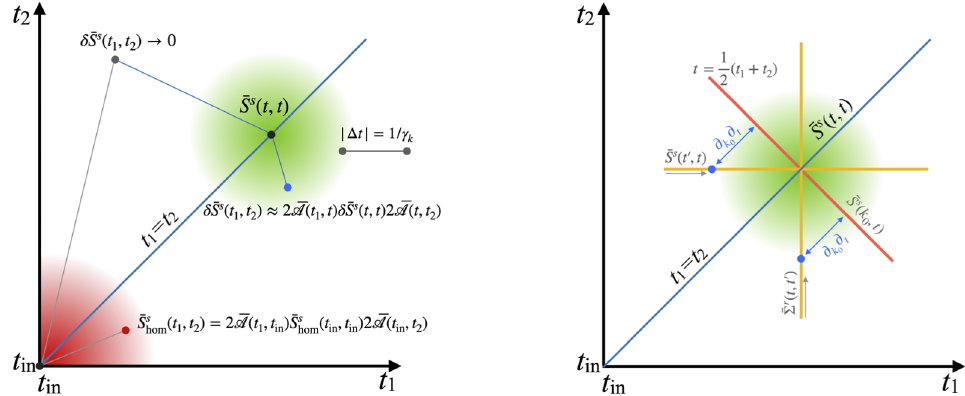
Figure 2. Left panel: schematics of the propagation of the homogeneous correlation from the initial condition set at ( t 1 , t 2 ) = ( t in , t in ) (red) and the extent of the non-local correlation around a local solution defined at ( t 1 , t 2 ) = ( t, t ) (green, see section 3.2). The strength of the colour illustrates the strength of the correlation. Outside the spheres, with | ∆ t | (cid:29) 1 /γ k , points are no longer correlated (with ( t in , t in ) and ( t, t ) respectively) because of the dissipation. Right panel: shown are the particular time-contours of relevance for the local equation as discussed in section